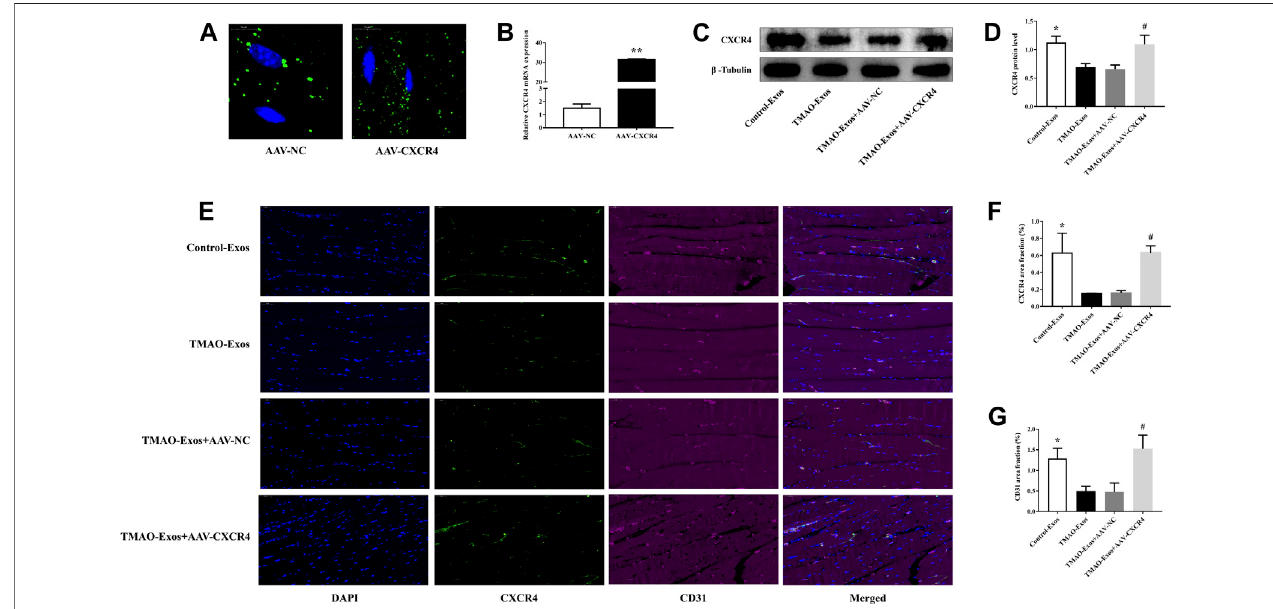
FIGURE 6 | TMAO-Exos reduced the capillary density and CXCR4 expression in vivo . (A) The GFP signals of AAV-NC and AAV-CXCR4 were still detectable in gastrocnemius muscles after 21 days. Bar: 10 μ m. (B) Transfection ofAAV-CXCR4 ef fi ciently increased the mRNAexpression ofCXCR4. n = 3,independent t -test was performed for comparisons; ** p < 0.01. The CXCR4 expressions detected by western blot (C,D) and immuno fl uorescence analysis (E,F) were notably decreased by TMAO-Exos and restored by overexpression of CXCR4. n = 6 for western blot, n = 3 for immuno fl uorescence analysis, one-way ANOVA followed by LSD test for pairwise comparisons wereapplied; * p < 0.05,# p < 0.05versustheTMAO-Exos groupandtheTMAO-Exos +AAV-NC group. Bar:50 μ m. (E,G) Thecapillarydensities (indicated by CD31 + cells) were signi fi cantly down-regulated but rescued by amplifying the expression of CXCR4. n = 3, one-way ANOVA followed by LSD test for pairwise comparisons were applied; * p < 0.05, # p < 0.05 versus the TMAO-Exos group and the TMAO-Exos + AAV-NC group. Bar: 50 μ m. All data were expressed as mean ±